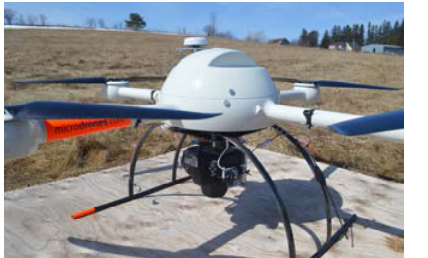
Figure 2: Microdrones md4-1000 VTOL UAV with the APX-15